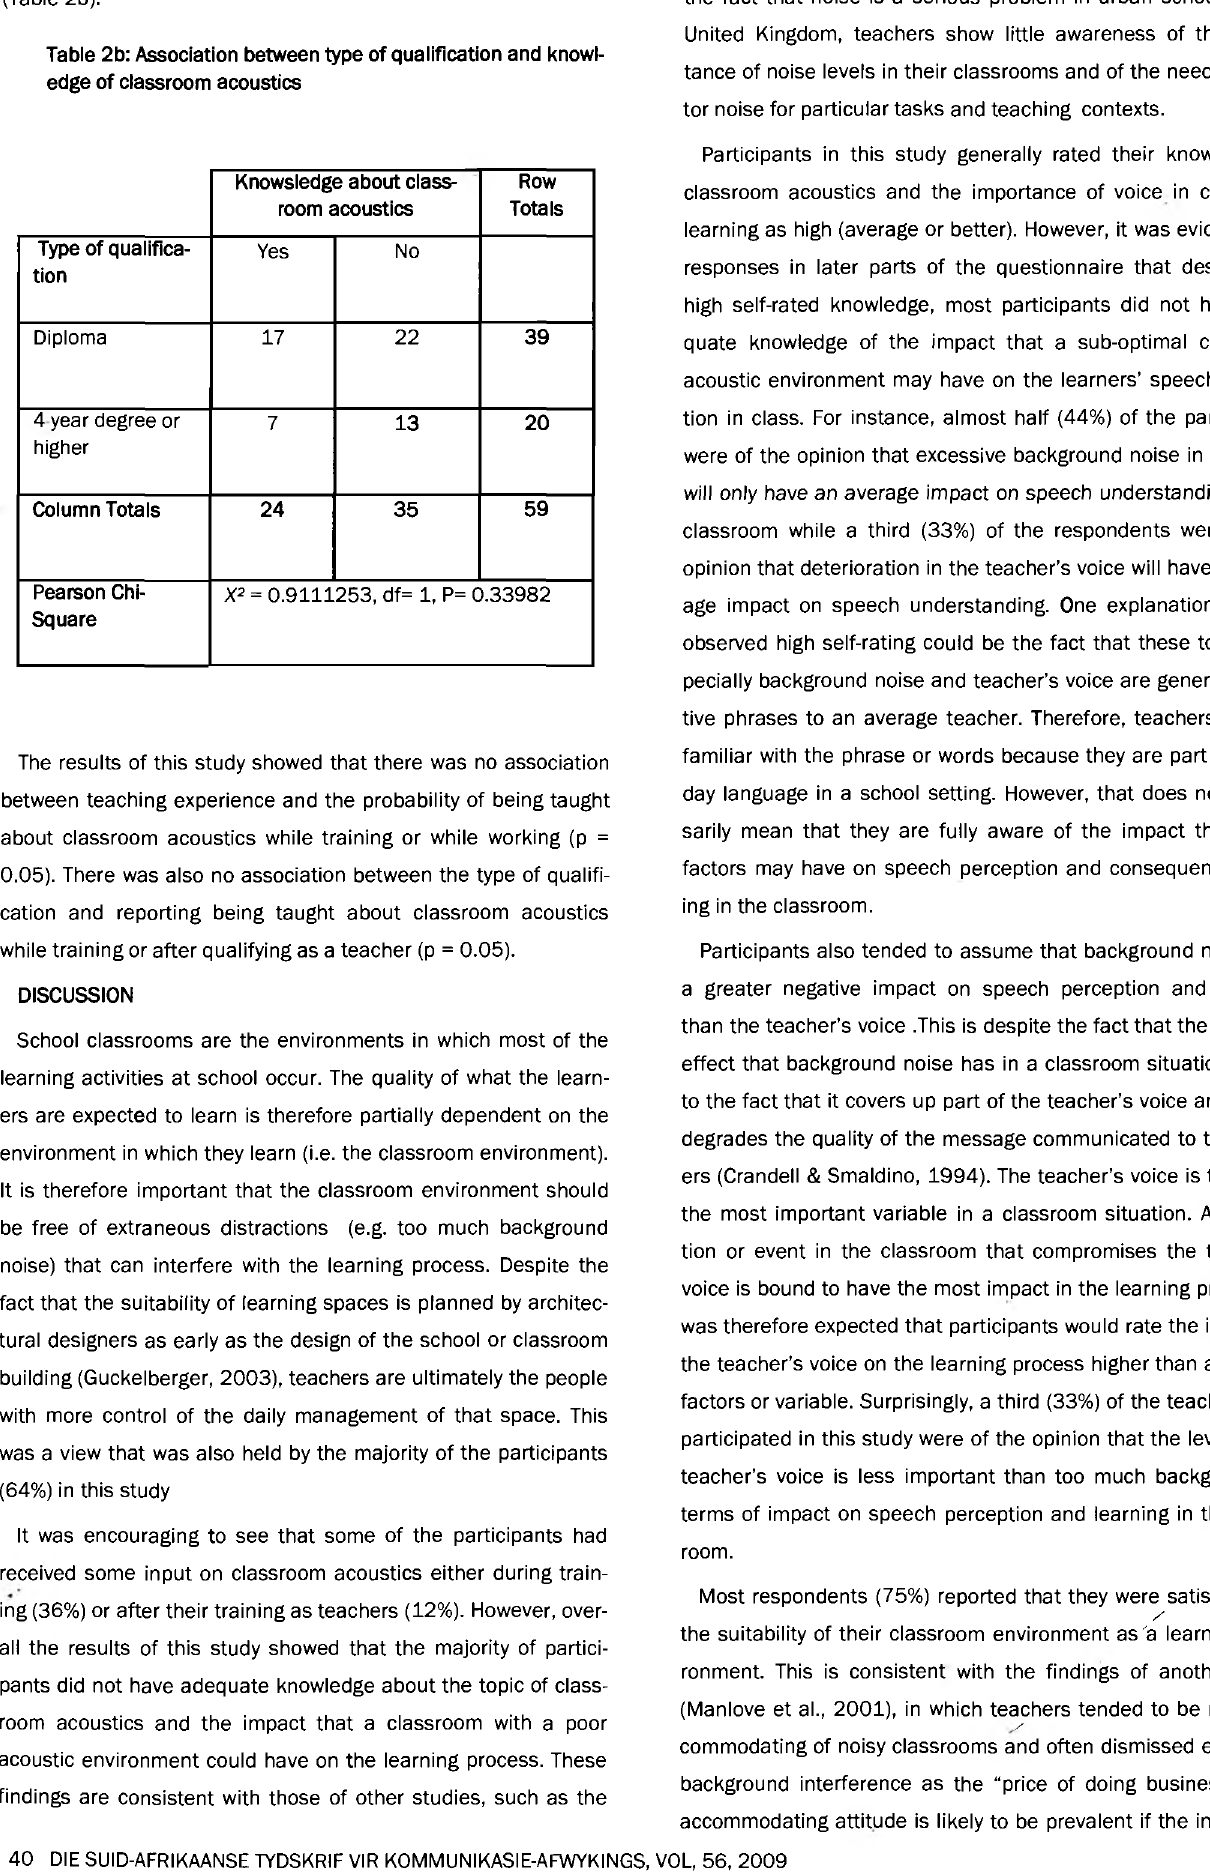
Table 2b: Association between type of qualification and knowl­ edge of